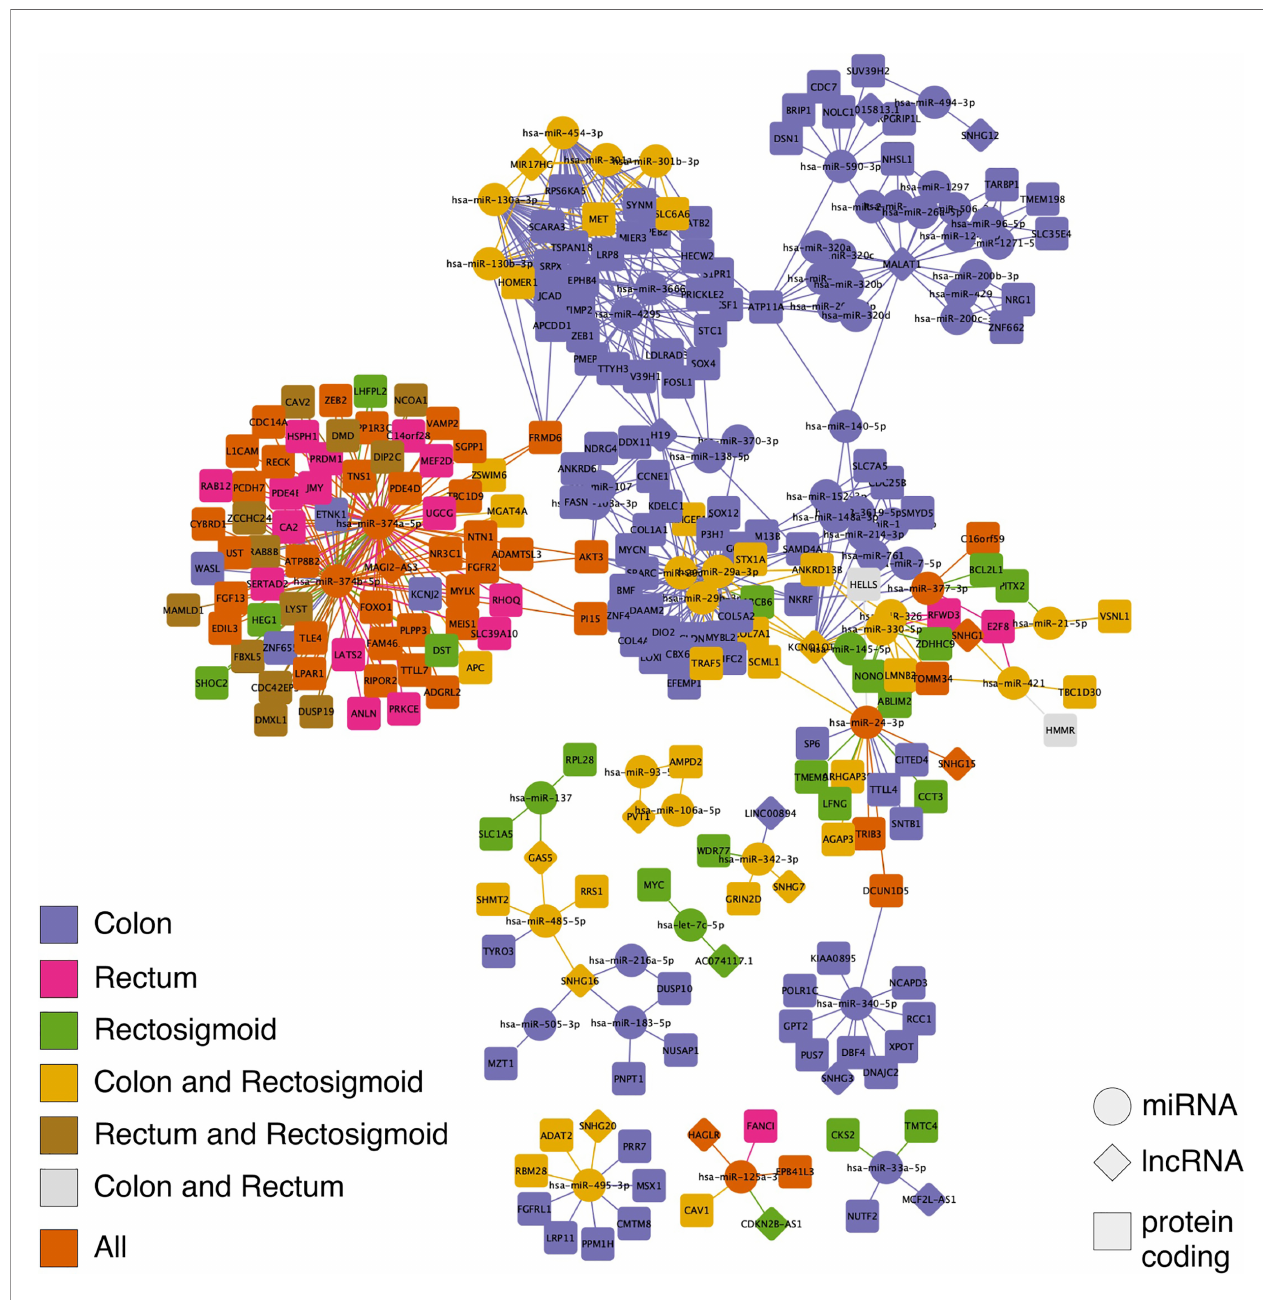
FIGURE 2 | Competing endogenous RNA (ceRNA) network in colon, rectum and rectosigmoid junction sites. The diamonds represent lncRNAs, the circles represent miRNAs, and the squares represent PCGs . The molecules and interactions of each CRC site can be identi fi ed by